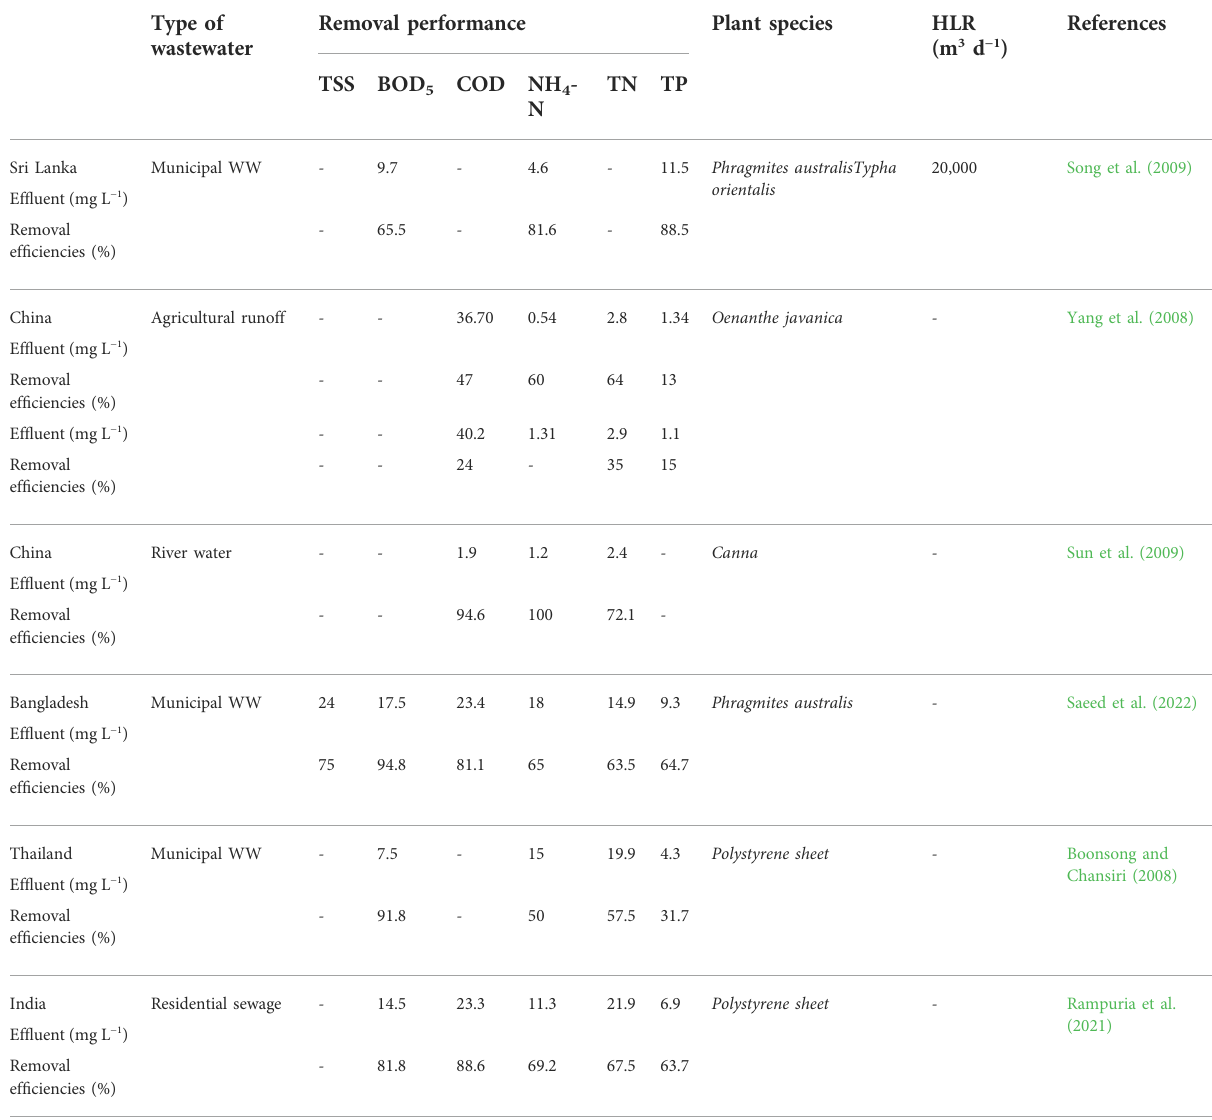
TABLE 3 An overview of the FTW system operating characteristics and treatment performances in Asian